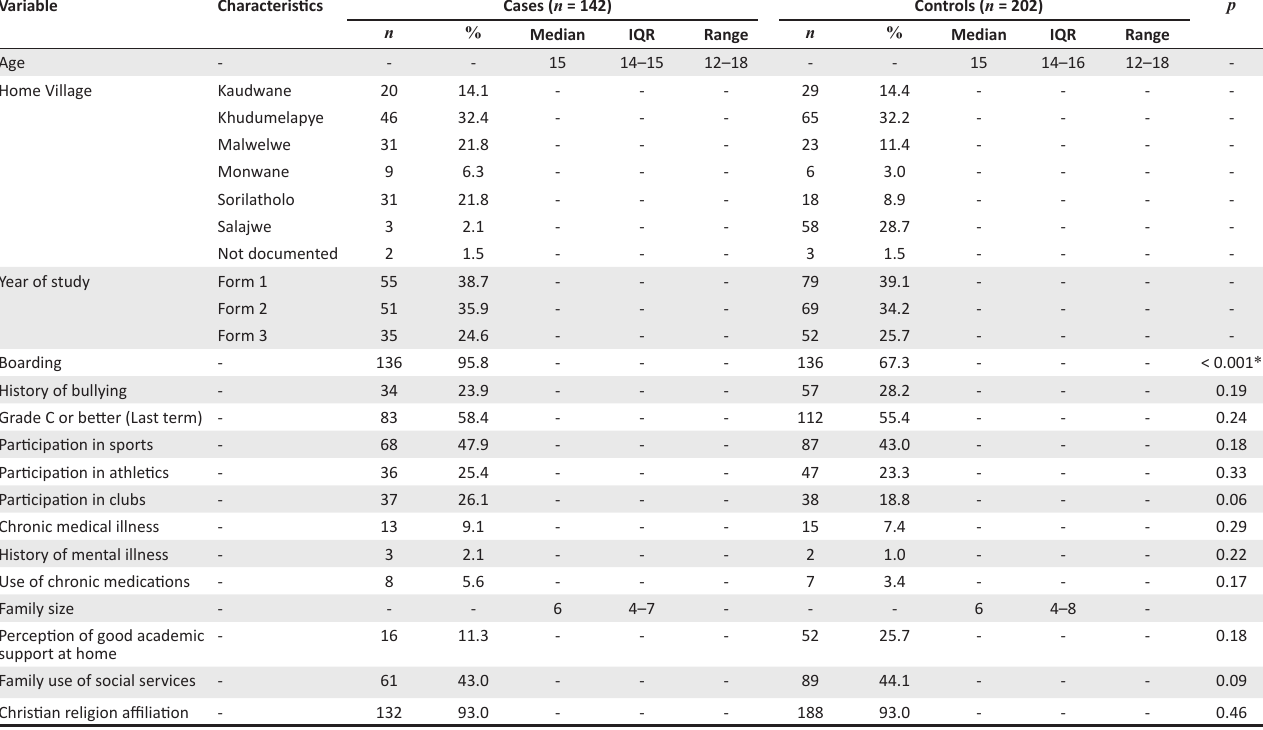
TABLE 1: Baseline characteristics of cases and controls.